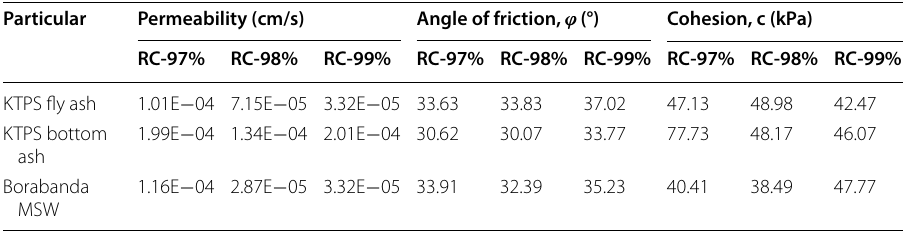
Table 3 Permeability and shear strength characteristics of KTPS fly ash, KTPS bottom ash and Borabanda